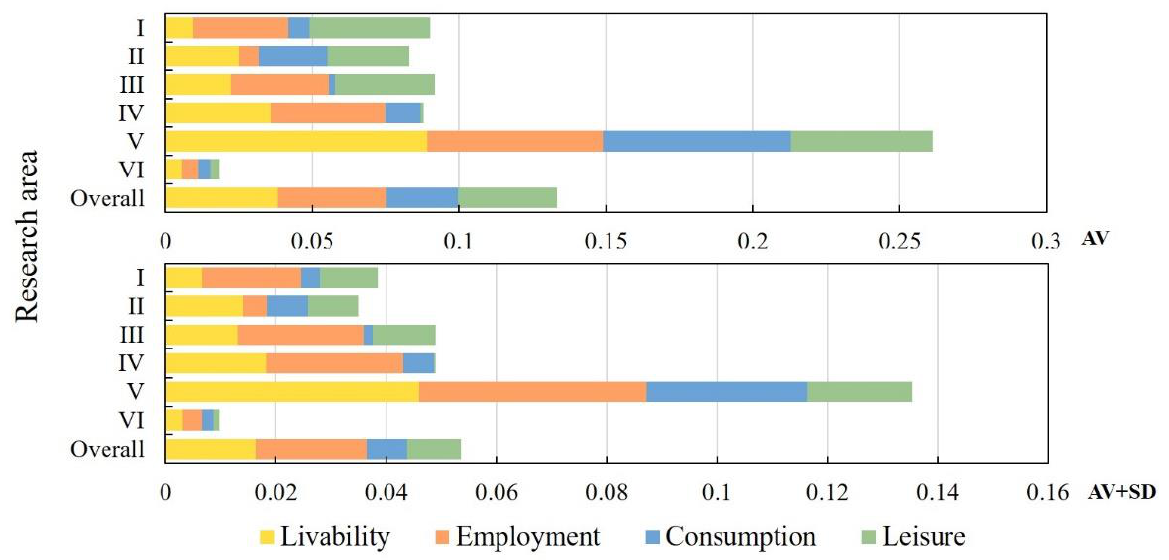
Figure 10. Basic characteristics of different types of enhancement areas.